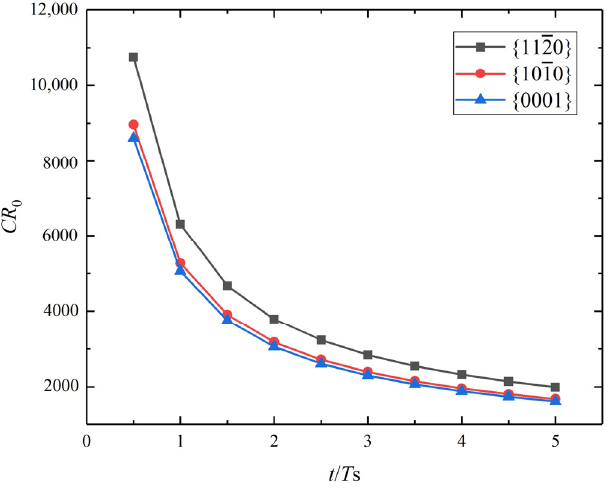
Figure 3. Dimensionless corrosion rate versus dimensionless time for three different crystallographic planes for Mg. Table 2. Surface energy density for different crystallographic planes of Mg [7].